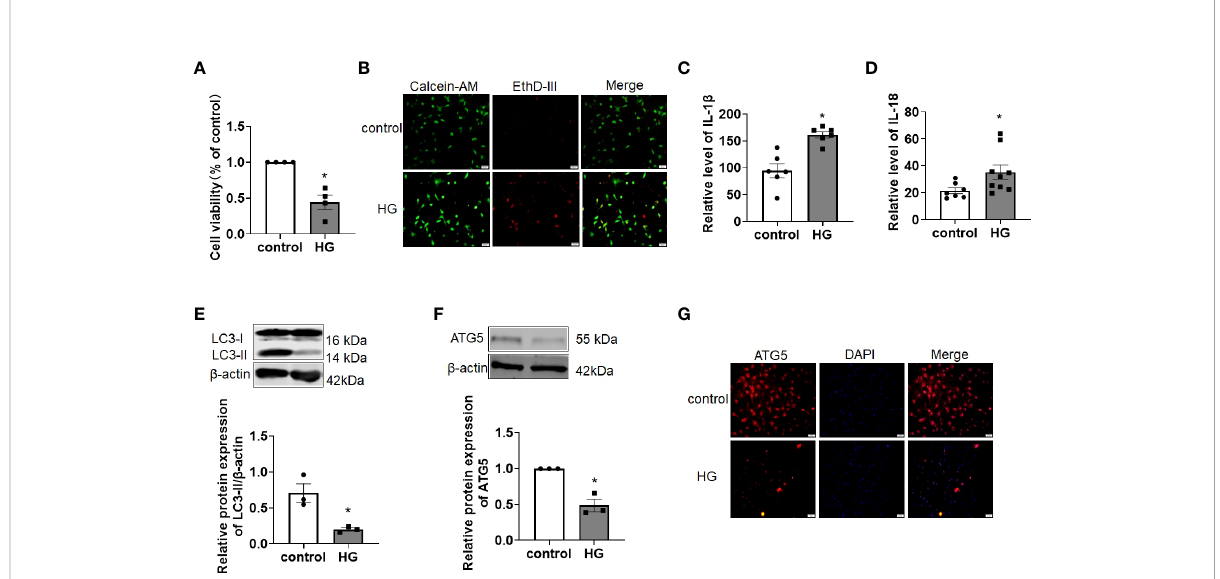
FIGURE 1 Autophagy was impaired in HG-treated primary cardiomyocytes. (A) The cell viability was detected by CCK-8 assay. n = 4 in each group. * P < 0.05 versus control. (B) The live (green) and death (red) cells were labeled with calcein-AM and EthD-III. (C, D) The levels of the proin fl ammatory cytokines IL-1 b (C) and IL-18 (D) were detected by ELISA assay. n = 6-9 in each group. * P < 0.05 versus control. (E, F) The levels of the autophagy-related proteins LC3-II (E) and ATG5 (F) were detected by western blot assay. n=3 in each group. * P < 0.05 versus control. (G) Immuno fl uorescence analysis was conducted to assess ATG5 (red) in primary cardiomyocytes of different groups. DAPI (blue) was used to stain the nucleus. HG, high